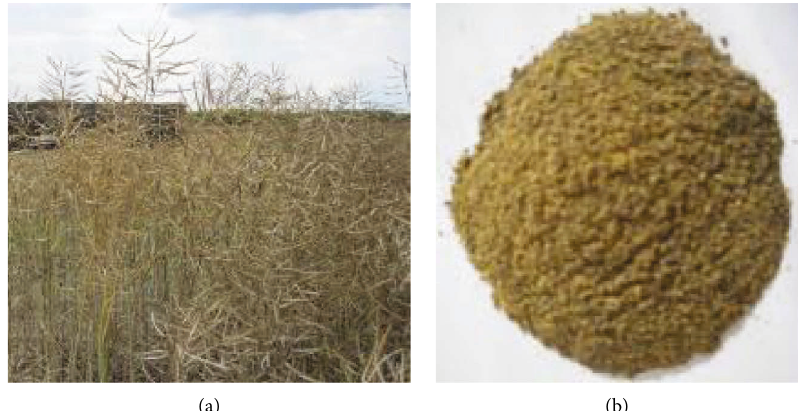
Figure 1: Rapeseed residual biomass: (a) straw, leaves, and pods; (b) residual rapeseed biomass ground and sieved to the particle size of ≤